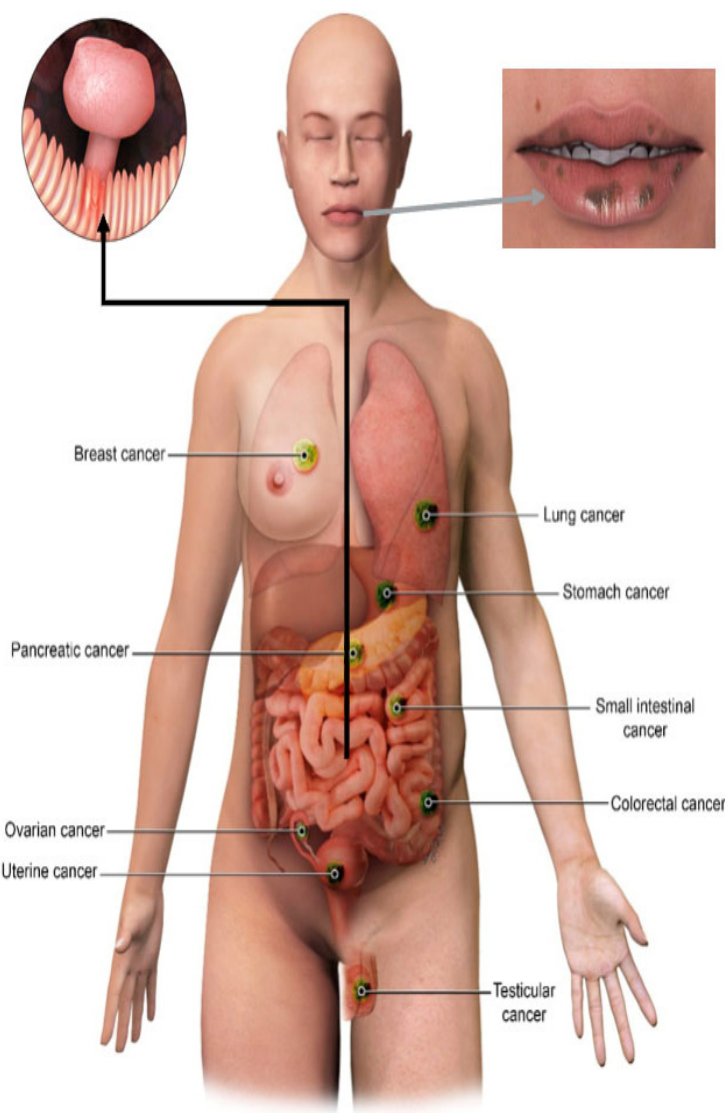
Figure 1. Manifestations of Peutz-Jeghers Syndrome include characteristic mucocutaneous pigmentations, hamartomatous gastrointestinal polyps, and an elevated risk of malignancy.